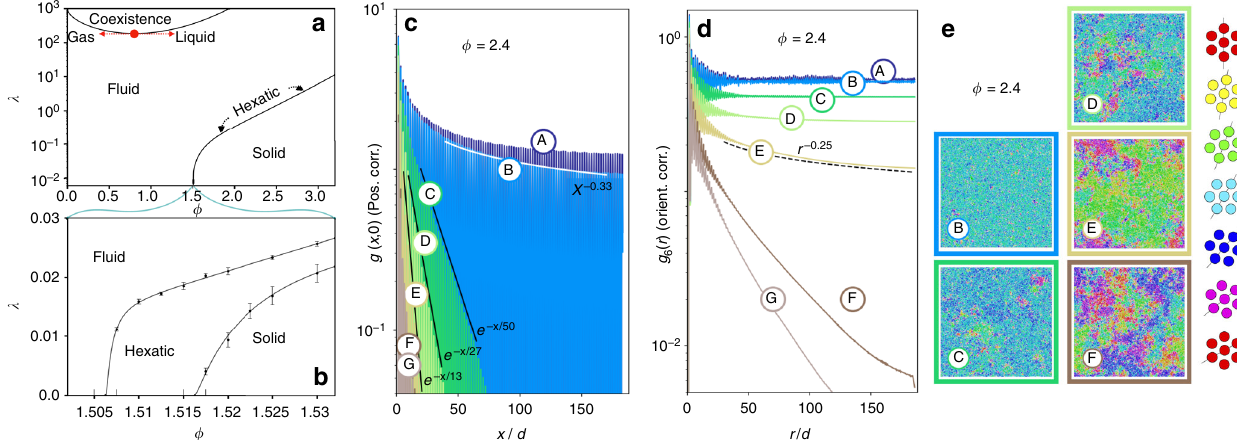
Fig. 2 Full phase diagram and two-step melting. Depicted results are for N ~ 4.4 × 10 4 particles and δ = 0.1. a Activity λ vs. density ϕ phase diagram. MIPS between a liquid and a gas, at high λ , is situated far above the solid – hexatic – liquid melting lines. The red dot indicates a possible critical point. b Two-step melting for small λ with shift of transition densities to higher values with increasing λ , preserving the equilibrium phases. Two-step melting from the solid is induced by density reduction (as in equilibrium) but also by an increase in λ . (See Methods for de fi nition of error bars.) c – e Activity-induced two-step melting high above the equilibrium melting densities ( ϕ = 2.4, A: λ = 0.987; B: λ = 0.999; C: λ = 1.018; D: λ = 1.033; E: λ = 1.045; F: λ = 1.064; G: λ = 1.079). c Positional correlation function g ( x , y ) along the x axis, in units of the global mean interparticle distance d = ( π N / V ) − 1/2 . d Orientational correlation function g 6 ( r ). e Snapshots of con fi gurations, particles colour-coded with their local orientation parameter ψ 6 . A and B are quasi-long-ranged in g ( x , 0) and long-ranged in g 6 ( r ), thus corresponding to the solid phase. C, D and E are short-ranged in g ( x , 0) and quasi-long-ranged in g 6 ( r ), thus corresponding to the hexatic phase. F and G decay exponentially in both correlation functions and thus correspond to a liquid. (For de fi nitions see